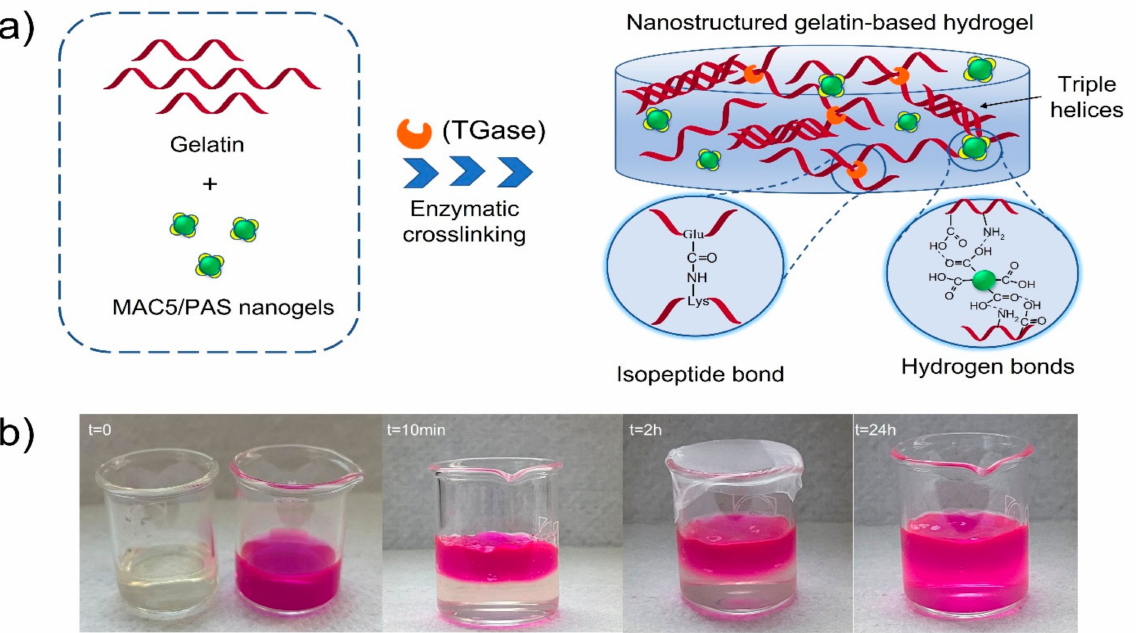
Figure 4. ( a ) Schematic illustration of the fabrication of TGase-crosslinked gelatin hydrogel loaded with MAC5/PAS nanogels. ( b ) Macroscopic self-healing behavior of HGel4 loaded with MAC5/PAS